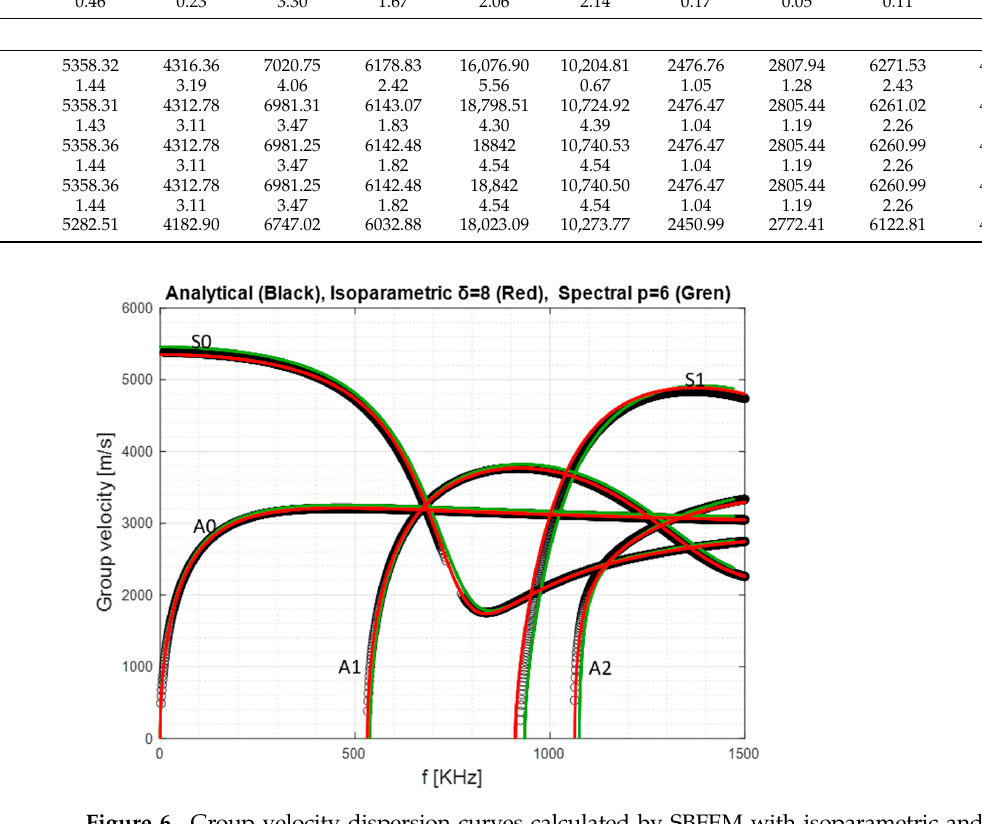
Figure 6. Group velocity dispersion curves calculated by SBFEM with isoparametric and spectral elements for a 3 mm-thick isotropic plate. Symmetric Sn and antisymmetric An (n=0, 1, 2,…) modes.